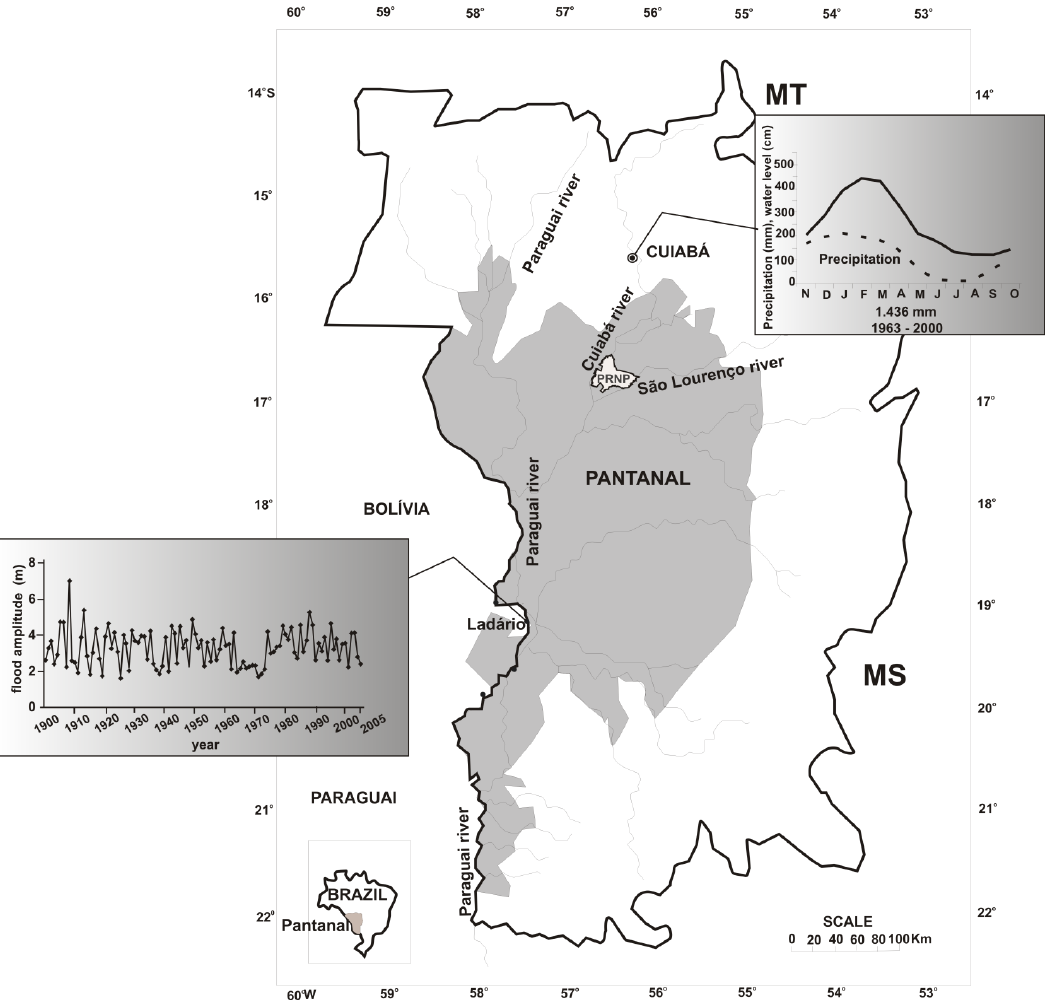
Fig. 1. Overview of the study site in N-Pantanal (SESC Pantanal Ecological Station) of Brazil. The inset figures indicate the seasonality in rainfall (city of Cuiab´a) and water level fluctuations (Cuiab´a River) as well as the interannual variation of the amplitude of the Paraguay River at the hydrological station in Lad´ario (data: